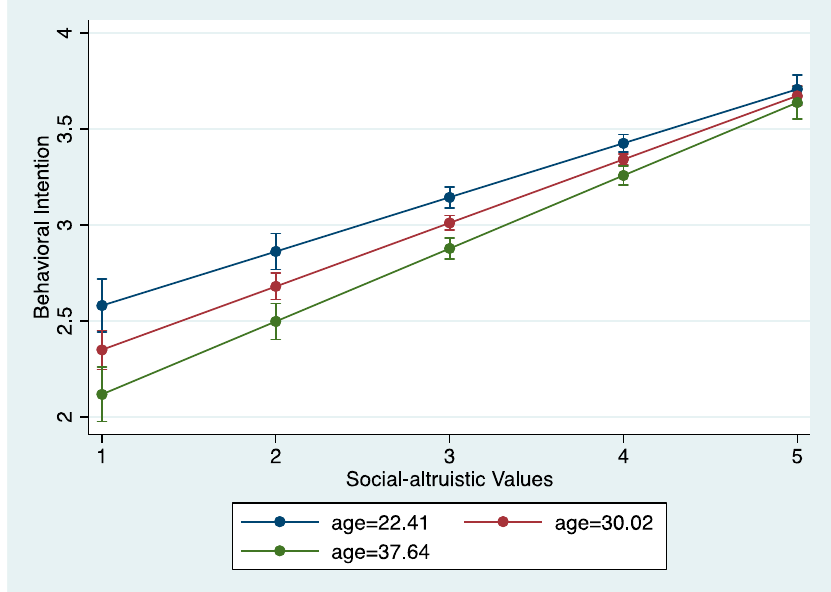
Figure 4. Interaction plot of age and altruistic values on behavioral intention.